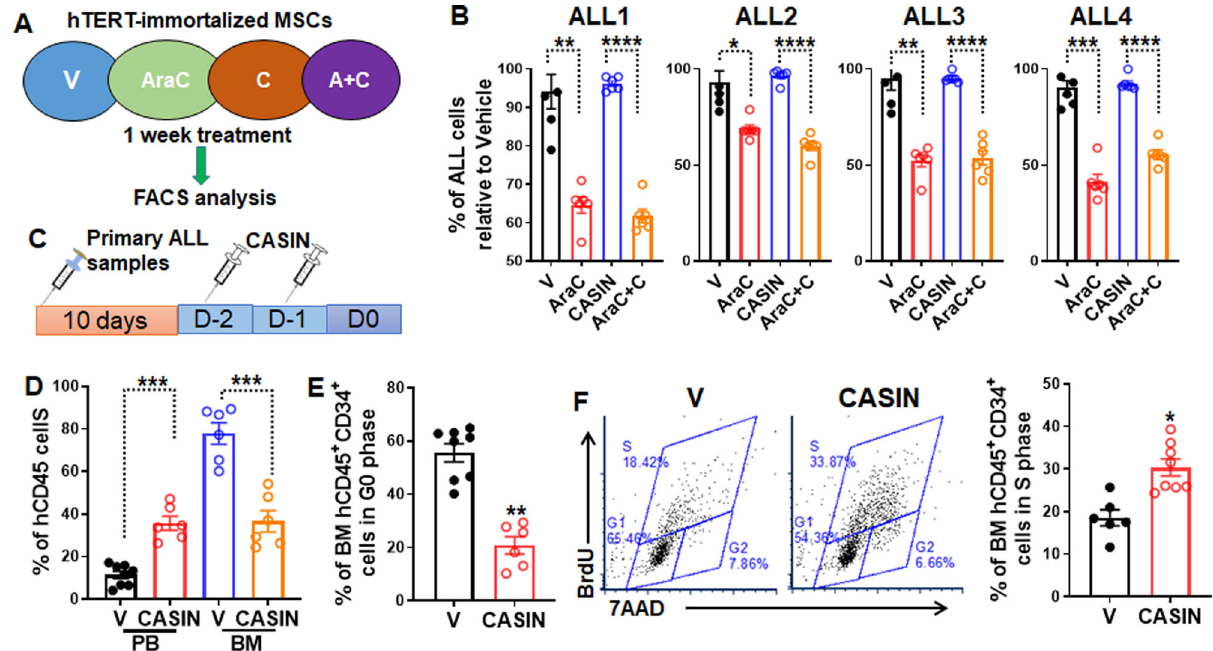
Fig. 7 CASIN mobilizes LSC-enriched ALL cells from the BM to PB. A Schematic presentation of experimental design. B CASIN does not further increase the cytotoxic effect of AraC on primary ALL cells in vitro. Primary ALL cells were cultured on hTERT-immortalized MSCs in the presence or absence